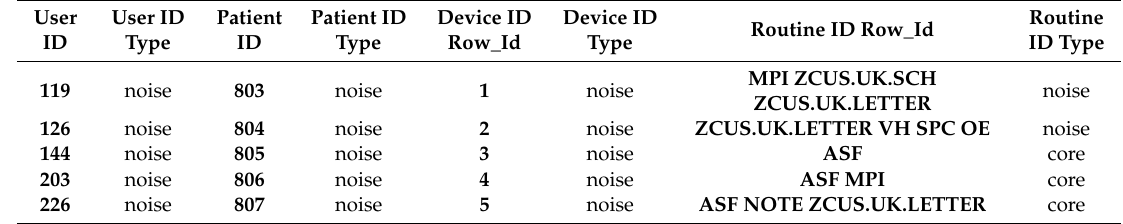
Table 5. Density-Based Spatial Clustering of Applications with Noise (DBSCAN)